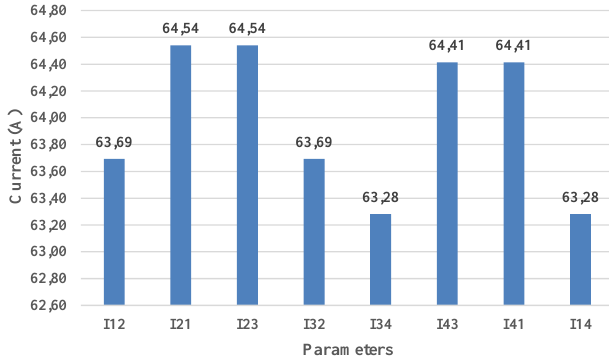
Figure 9. The DE simulation results for four-bus system.